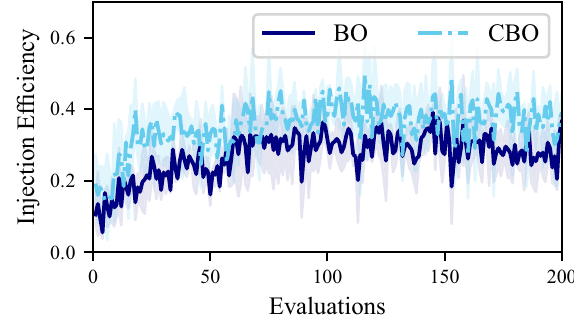
FIG. 10. Optimization results of BO (navy, solid) and con- textual BO (cyan, dashdot) on the six-dimensional problem. Each line is the averaged injection efficiency from three runs. By using the stored current as a context variable, CBO optimizes faster and obtains a consistently higher injection efficiency than normal BO after about ten